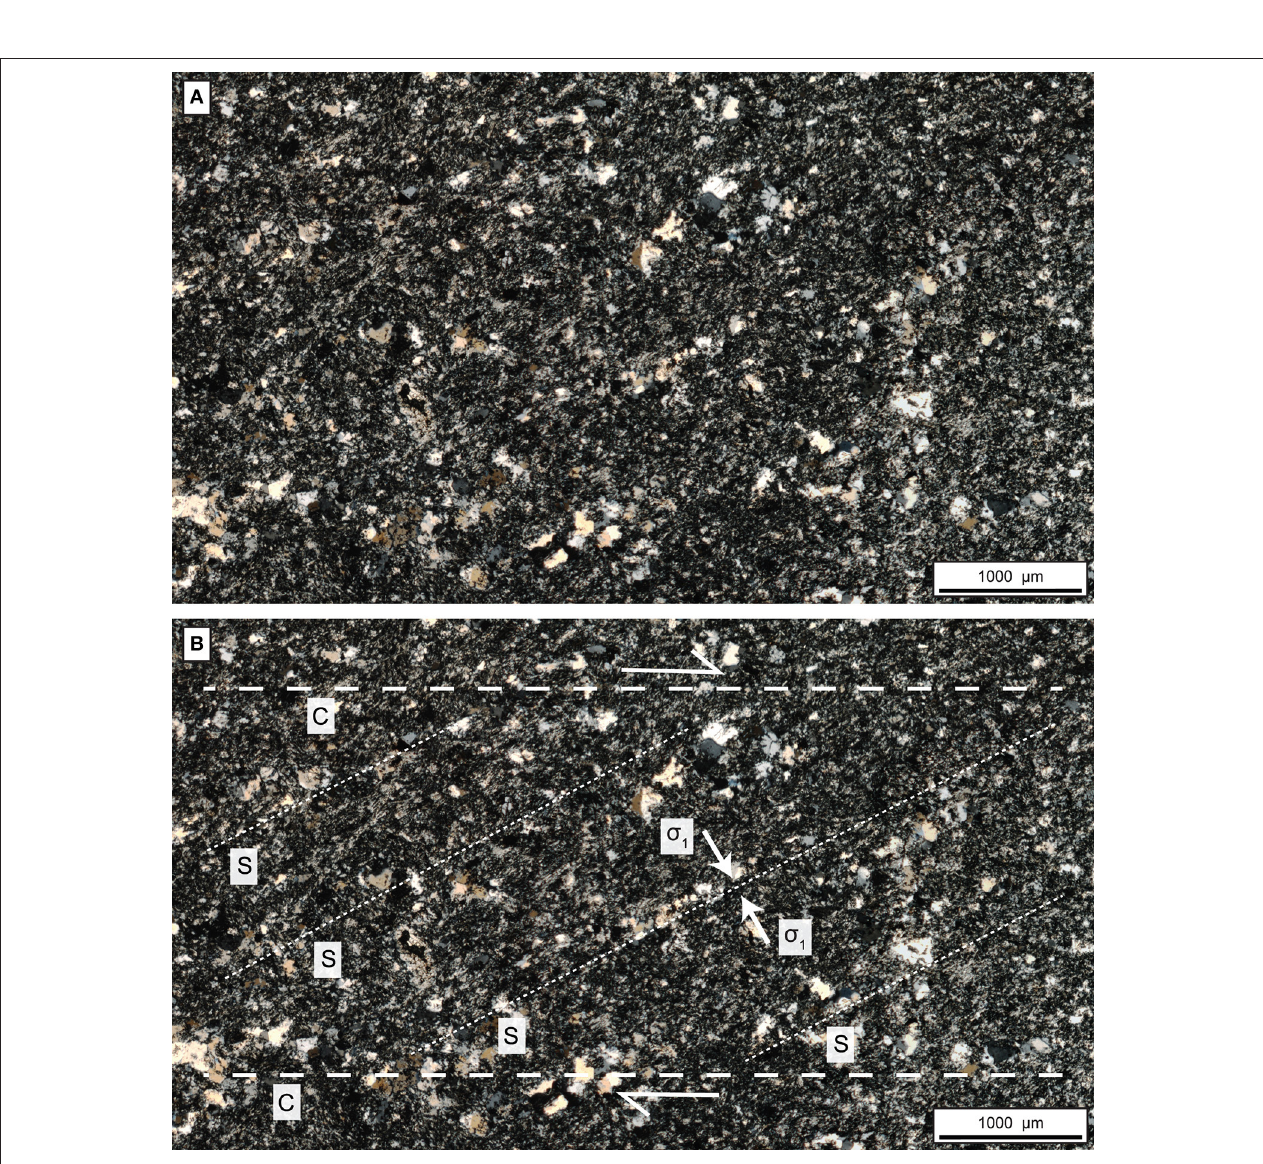
FIGURE 6 | Unannotated (A) and annotated (B) CPL photomicrographs of the same thin section of S-C fabric in flow-banded rhyolite. The sample is from the NW part of the main body of the Sandfell laccolith. Thick dashed white lines designate C planes and thin dashed white lines S planes in (B) . The thin section is oriented parallel to the magnetic lineation. S-C fabrics have been identified in the studied flow-banded samples from the northern part of main body of the Sandfell laccolith (see Figure 7A ).